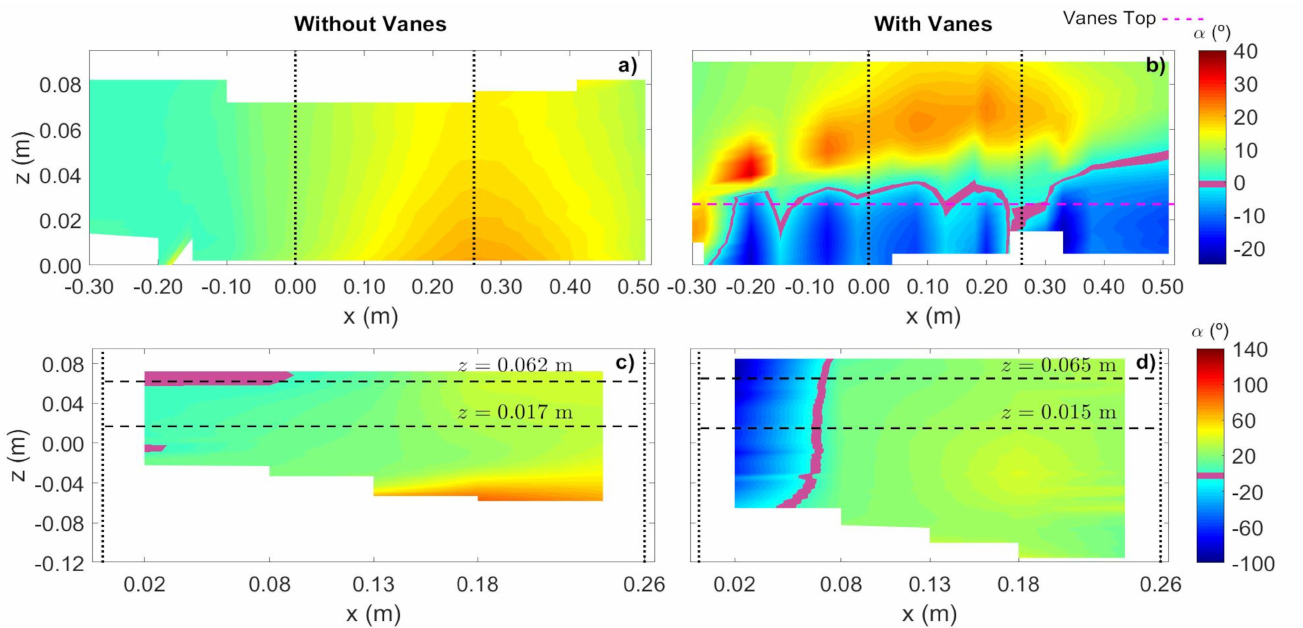
Figure 10. Distribution of the flow deflection angle α ( ◦ ) along plane xz , in the NV and the VF experiments, at: ( a ) y = 0.46 m. ( b ) y = 0.46 m. ( c ) y = 0.67 m. ( d ) y = 0.67